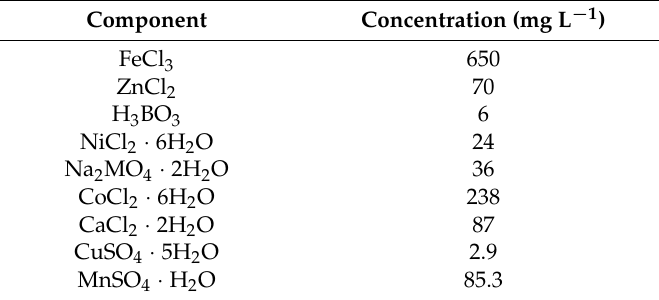
Table A3. Composition of trace elements solution.